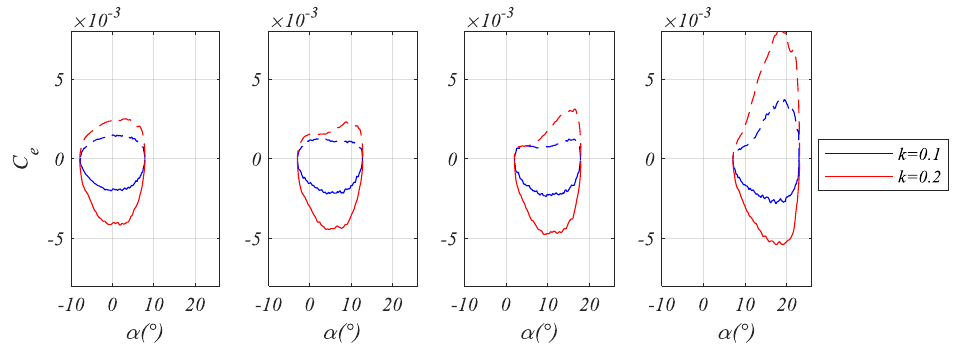
( b ) Figure 18. Tuft flow visualization: 15° ± 8°: ( a ) 9.9° downstroke, k = 0.1, ( b ) 9.8° downstroke, k = 0.2. 3.2.3. Impact of Oscillation on Aerodynamic Damping Whether energy is transferred from the flow to the wing or the opposite, during its